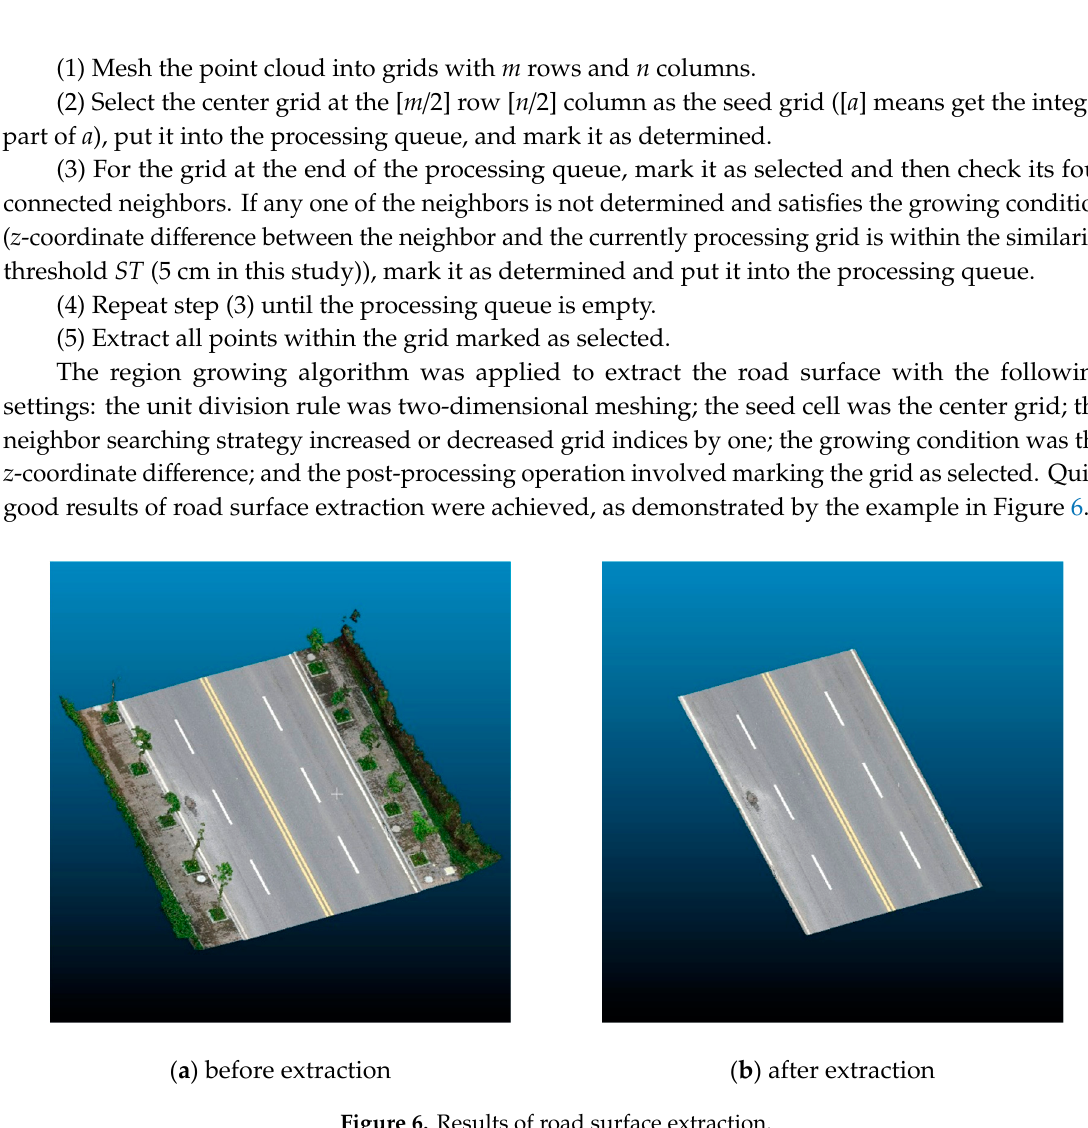
Figure 6. Results of road surface extraction.